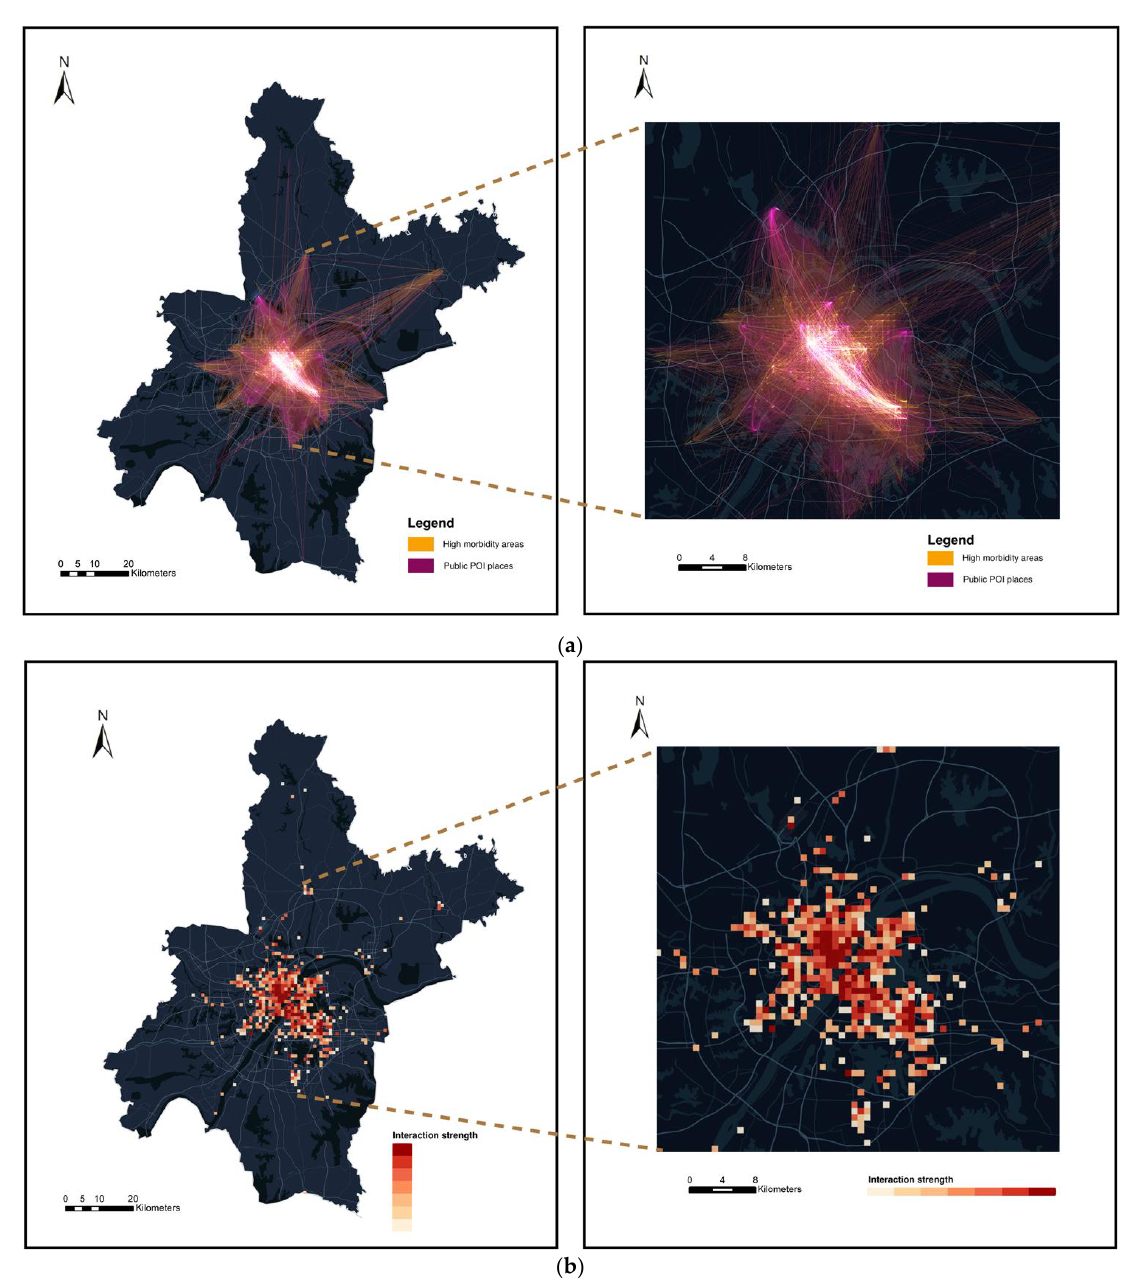
Figure 7. ( a ) Spatial interaction of high-morbidity residential areas and public POI sites. ( b ) Spatial distribution of high-risk public POI sites.